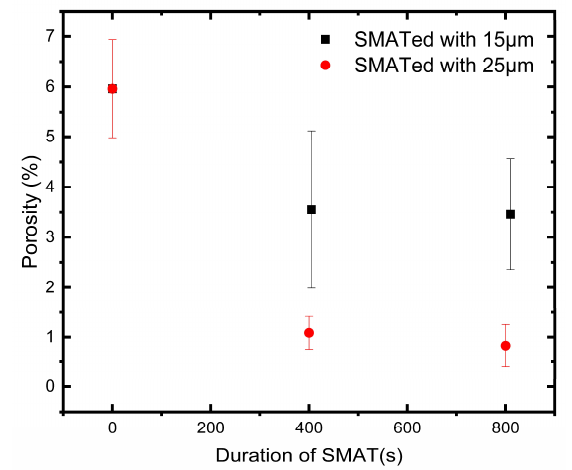
Figure 4. Coating porosity as a function of SMAT duration and amplitude.